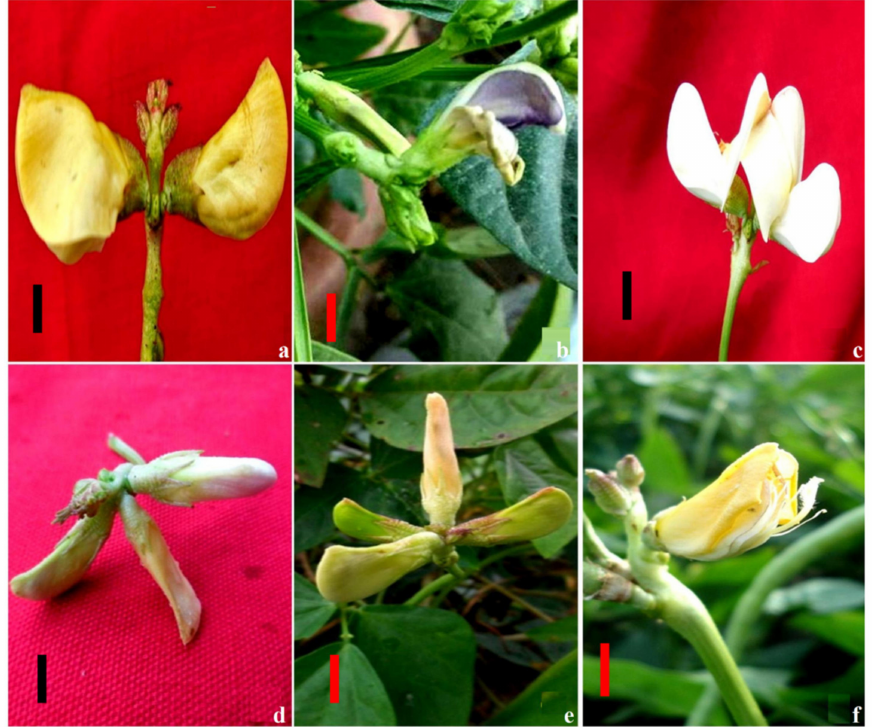
Figure 8. Representative photographs of gamma rays and sodium azide-induced alterations in the number and color of flowers per peduncle. ( a ) Yellow flowers in control, ( b ) blue-colored petals, ( c ) white flowers, ( d ) three flowers per peduncle, ( e ) four flowers per peduncle, and ( f ) open flower. Scale Bar = 1